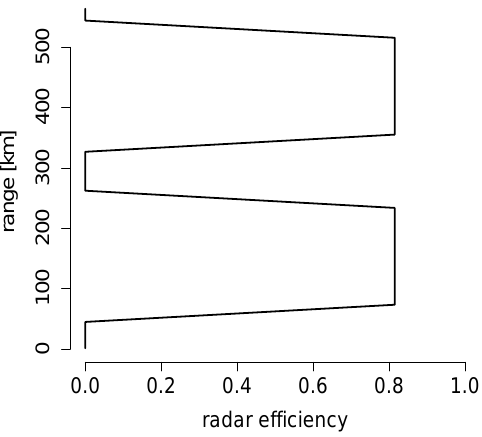
Fig. 5. Radar efficiency for experiment 2 introduced in this paper. (red) bits are drawn as separete curves. The black curve is the total efficiency. Table 2. Code sets used in experiment 2. If Barker codes are used the bit length in fourth column is that of the Barker